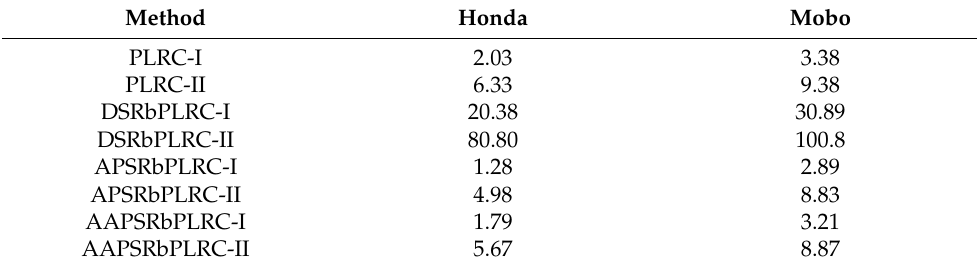
Table 2. The testing times for identifying a query video, on the Honda and Mobo